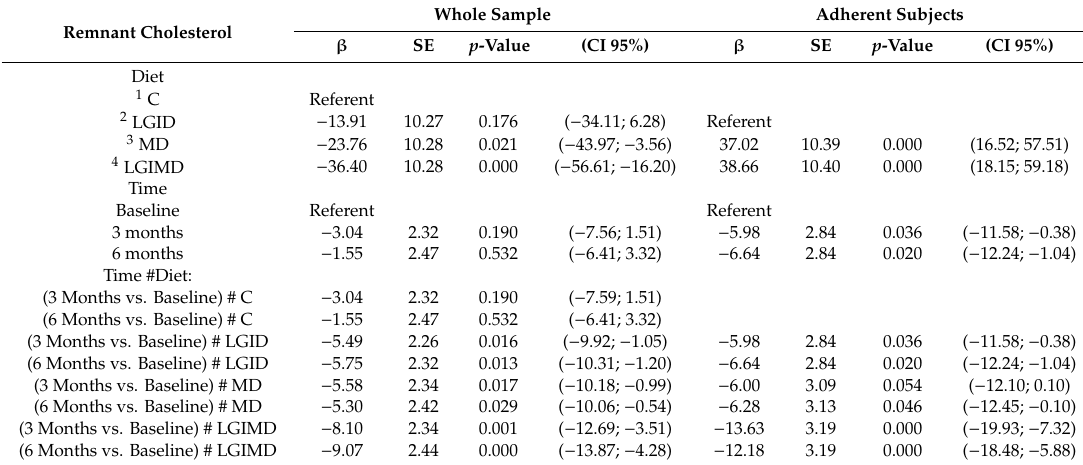
Table 3. Repeated measures analysis of variance. Principal e ff ects of diets and time and contrast of time within each level of diet in the whole sample and adherent subjects.